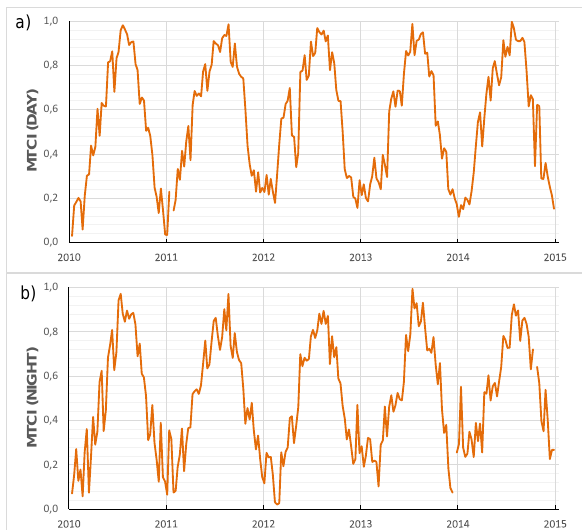
Figure 2. Temporal cycle of MTCI-day (a) and MTCI-night (b).